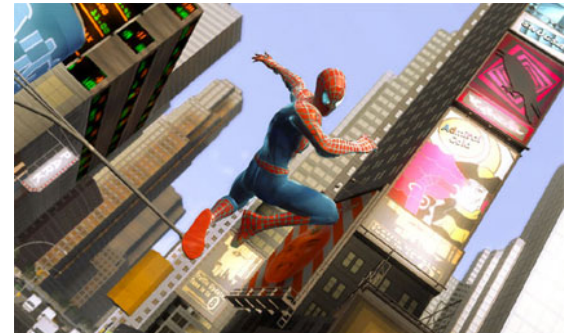
Figure 6. Three-dimensional graphics processing taken from the Videogame Spider-Man 3 "Live".